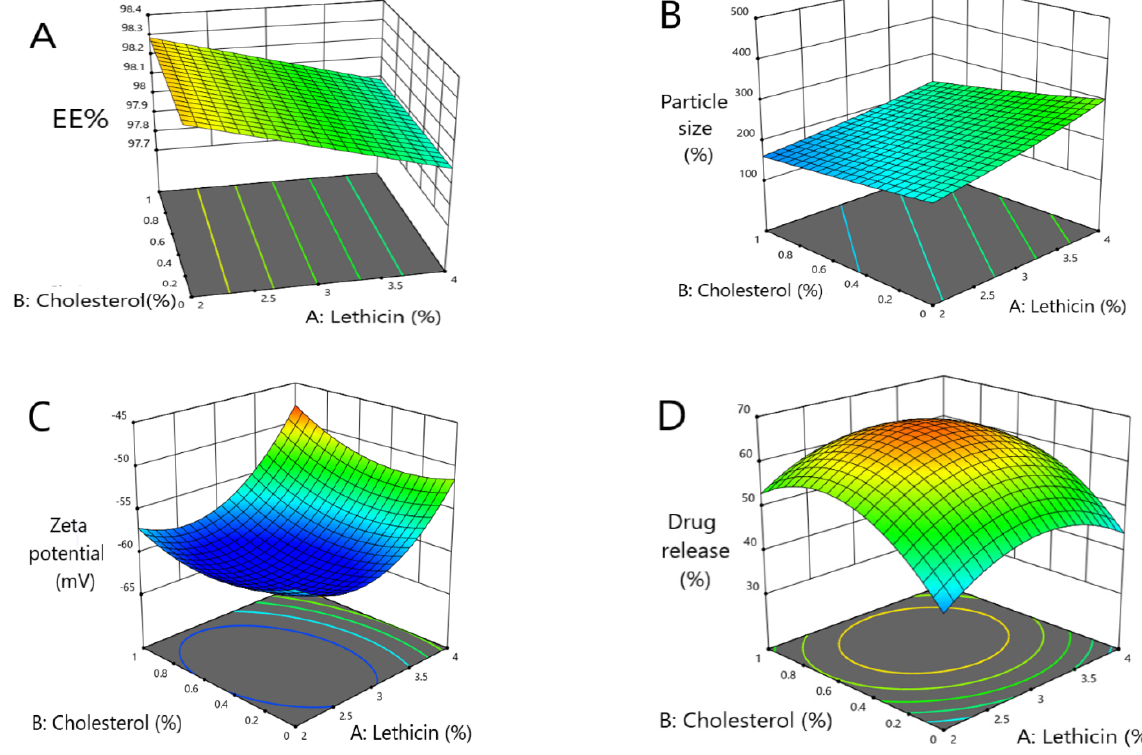
Figure 1. Three-dimensional response surface plots presenting the influence of the independent variables on ( A ) the EE%, ( B ) vesicles size, ( C ) ZP and ( D ) percent of drug released after 8 h.